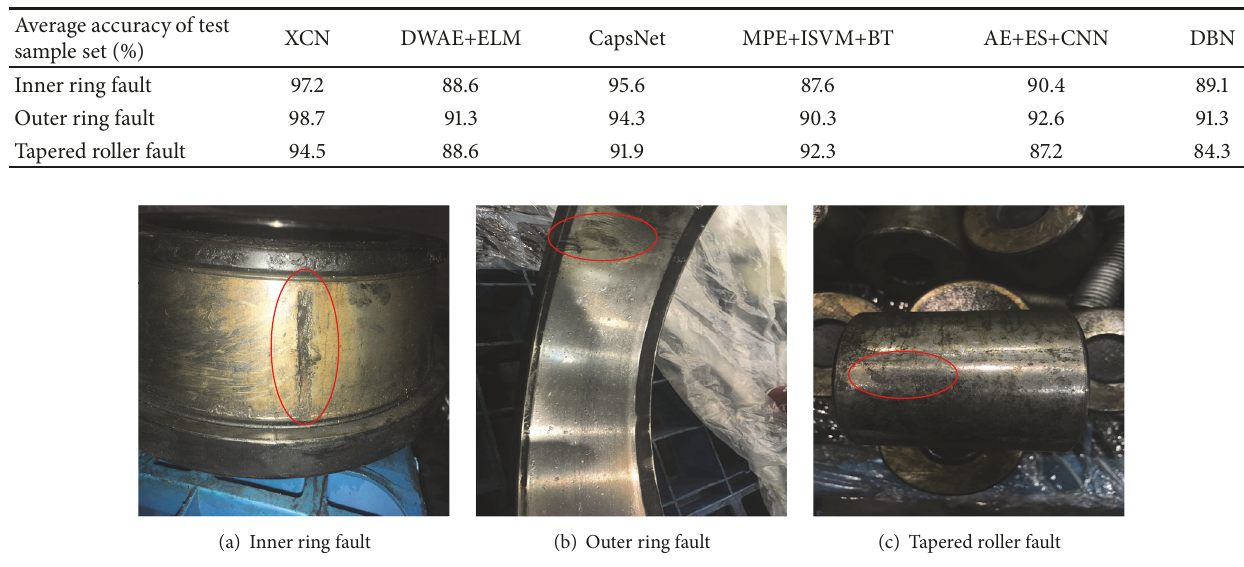
Table 4: Average classification accuracy of different algorithms.